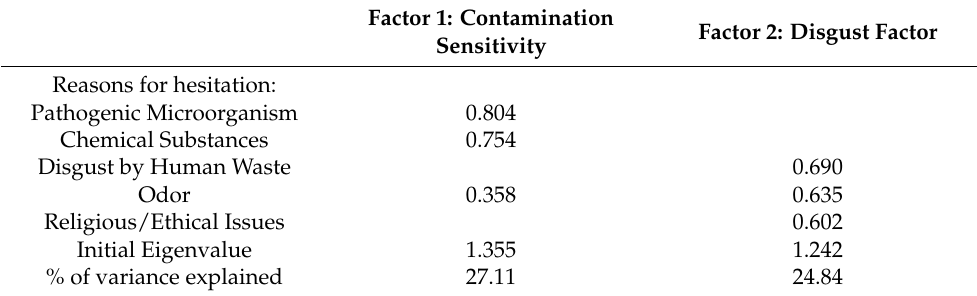
Table 4. Rotated component matrix on wastewater reuse